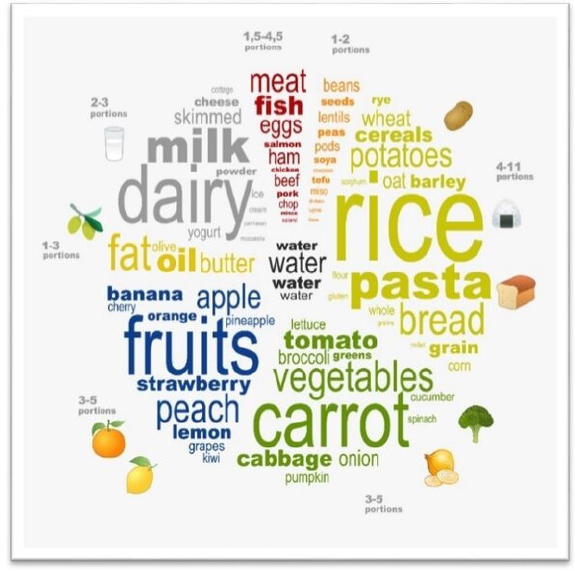
Figure 1. Mediterranean food pie chart.